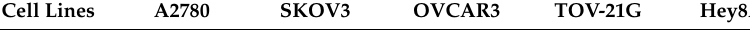
Table 1. E ff ect of DWP05195 on cell viability in human ovarian cancer cells. Cell